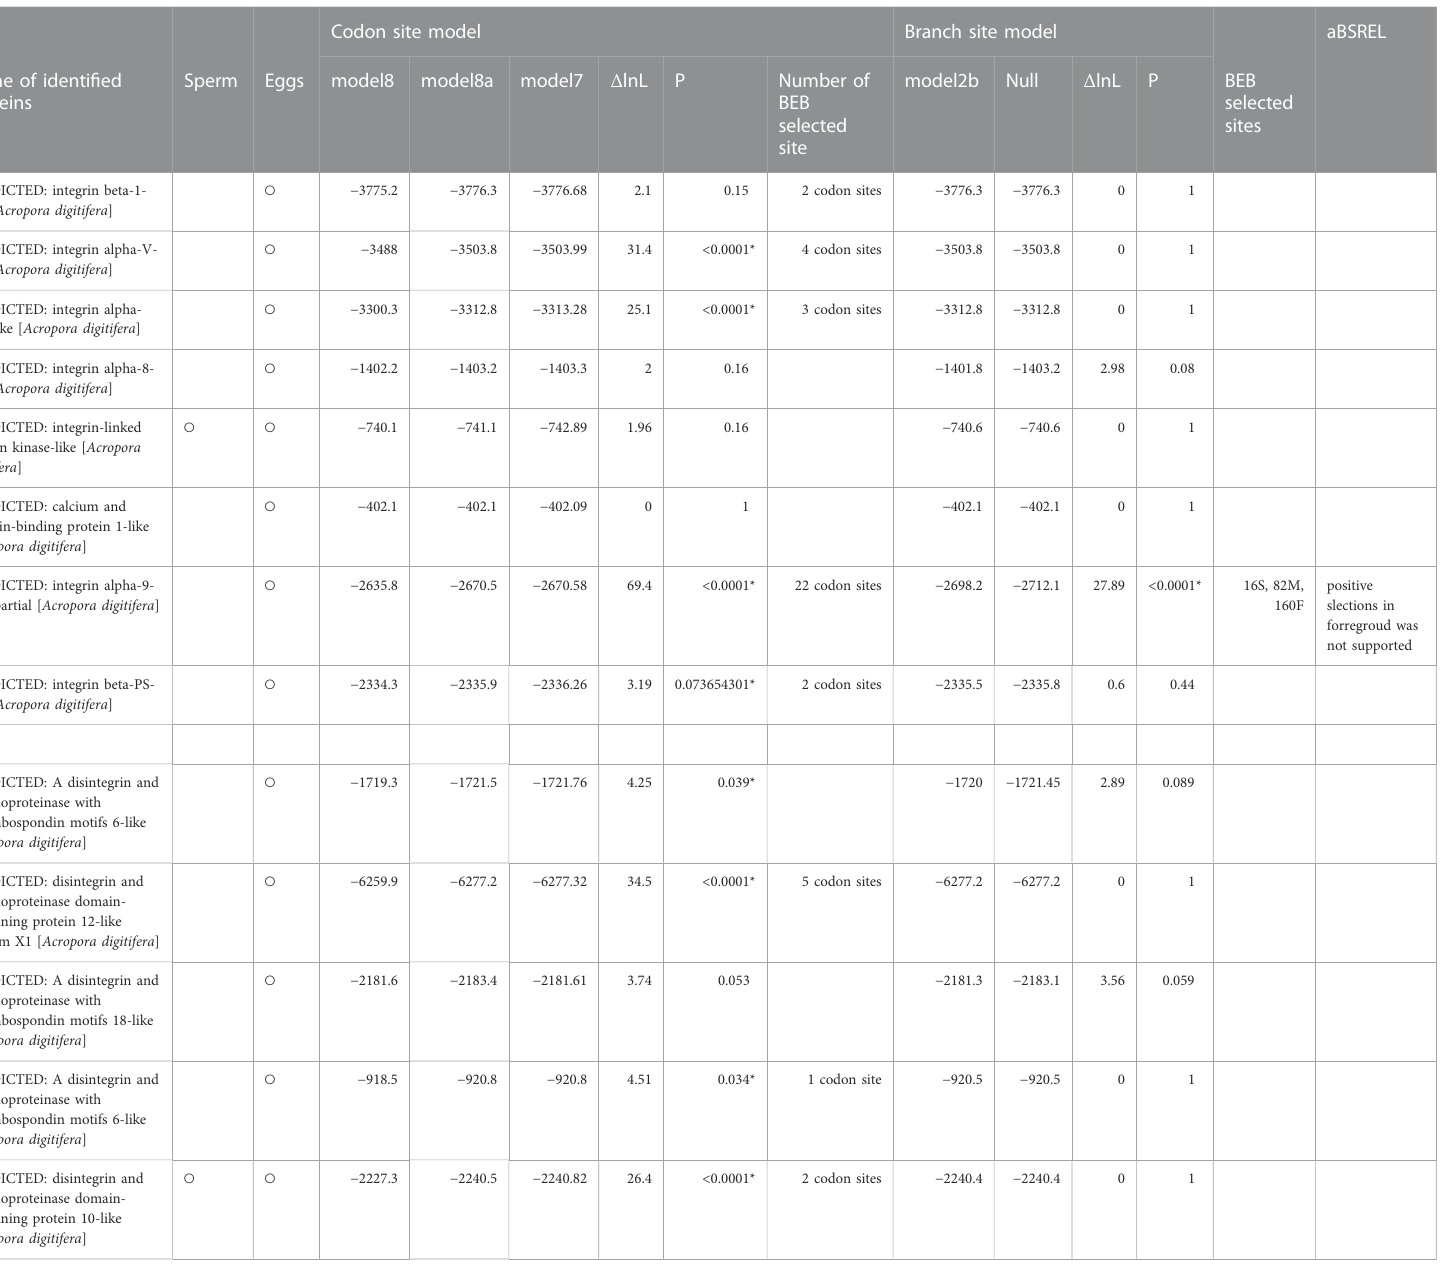
TABLE 1 Identi fi ed ADAM-Integrin and tetraspanin family in sperm and egg